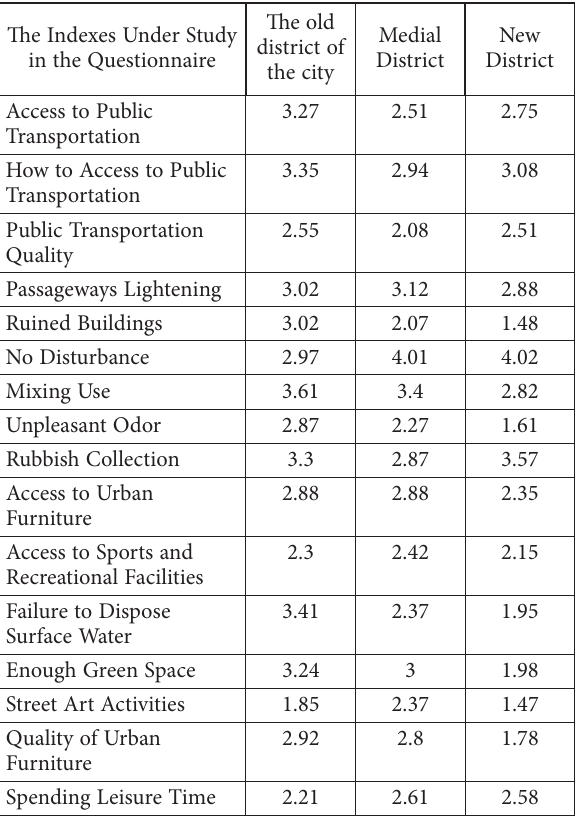
Table 4. Calculating the obtained index in each district